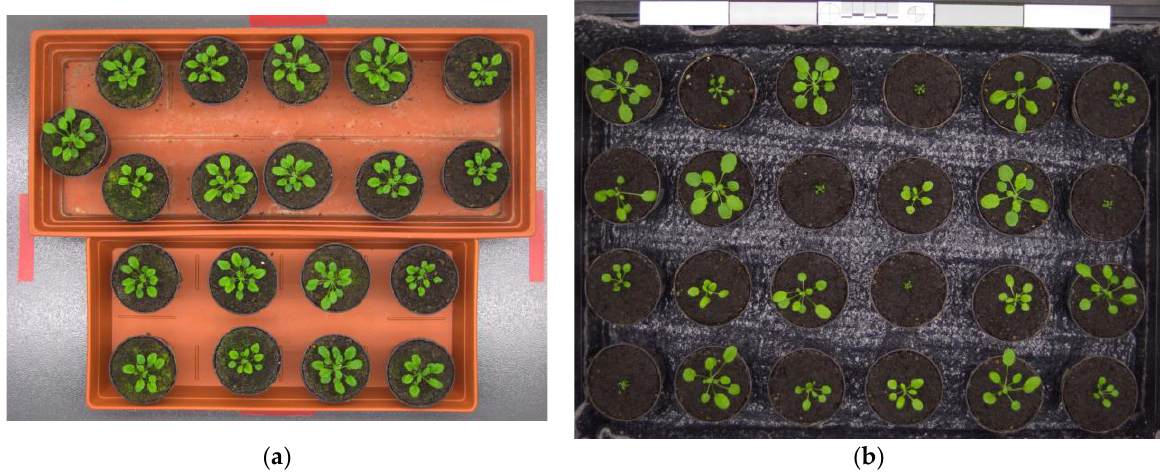
Figure 14. Image datasets of Arabidopsis thaliana plants [12,39,40]: ( a ) Ara2012; ( b ) Ara2013.